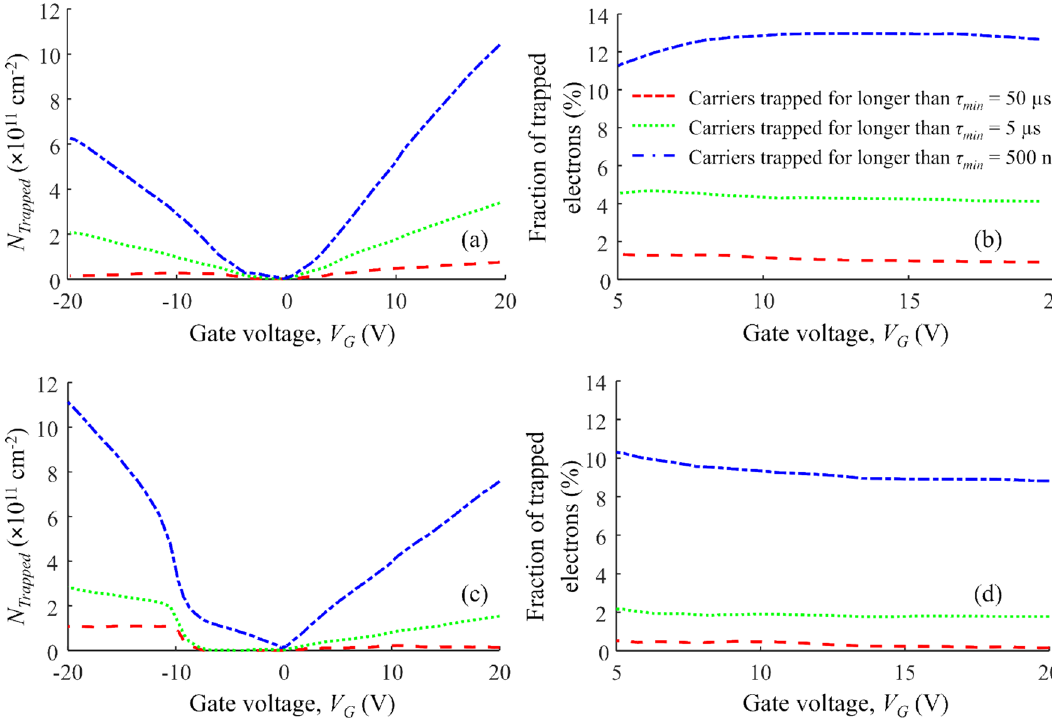
Figure 5. ( a ) The density of trapped charge with response times longer than τ min = 50 µs, 5 µs, and 500 ns for Manufacturer A; ( b ) the fraction of electrons trapped for longer than τ min , for Manufacturer A; ( c ) the density of trapped charge with response times longer than τ min = 50 µs, 5 µs, and 500 ns for Manufacturer B ( d ) the fraction of electrons trapped for longer than τ min for Manufacturer B.